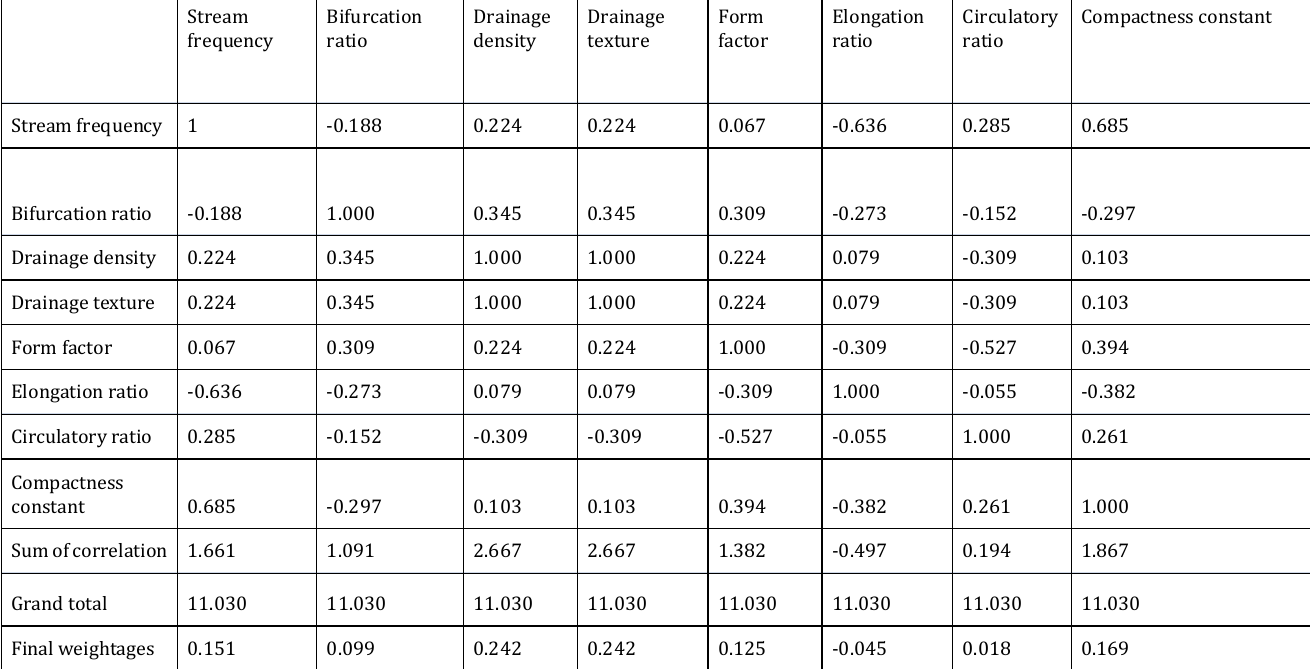
Table 13: Correlation matrixes of morphometric parameters of upper watershed of river Subarnarekha